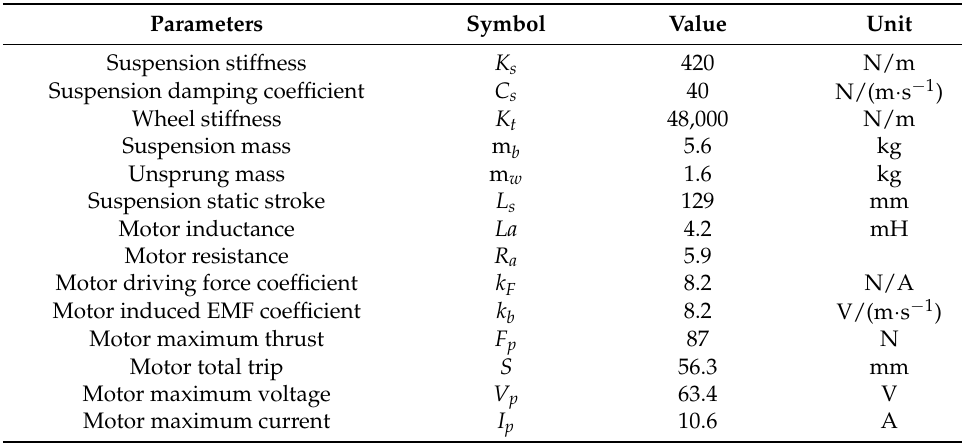
Table 1. System parameters in the quarter-car active